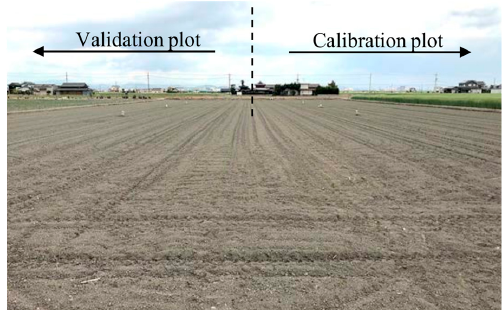
Figure 2. The converted field in this study. The field was divided into a calibration plot and a validation plot.